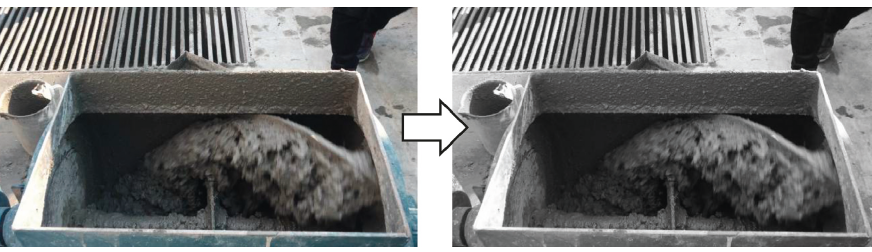
Figure 6: Converting the RGB images to